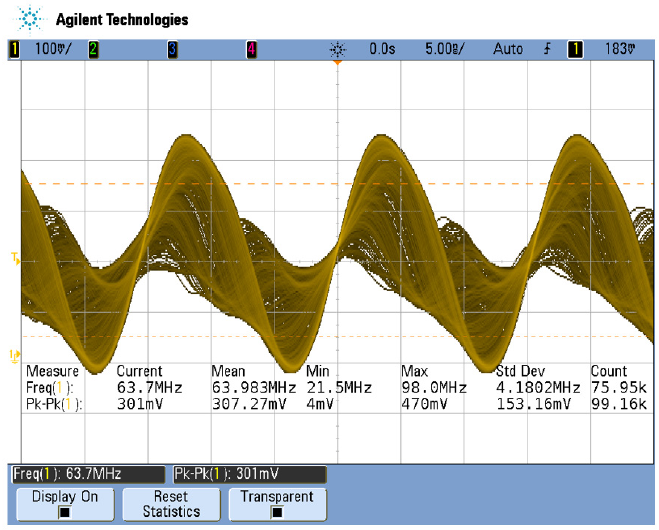
Figure 9. Test waveform diagram of the output signal of AD835 mixer.